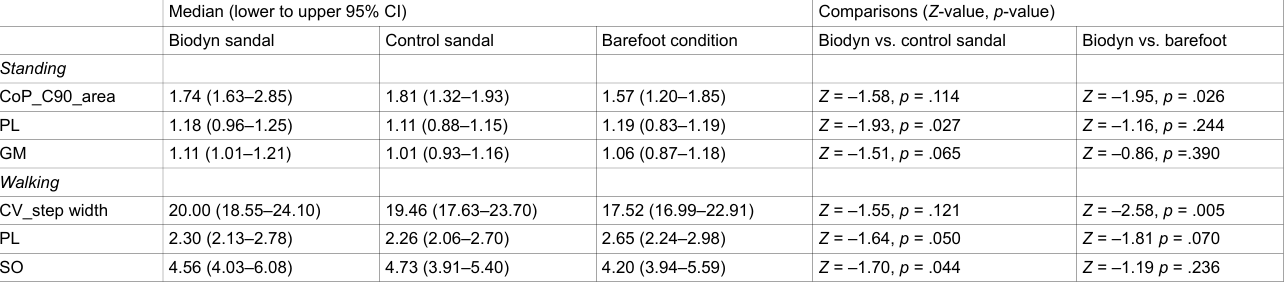
Table 2: Median (lower to upper 95% CI), Wilcoxon statistics ( Z -value), and Bonferroni corrected p -values for the three testing conditions (Biodyn sandal, control sandal and barefoot) separated into standing and walking performance. Median (lower to upper 95% CI) Comparisons ( Z -value, p -value) Biodyn sandal Control sandal Barefoot condition Biodyn vs. control sandal Biodyn vs. barefoot Standing